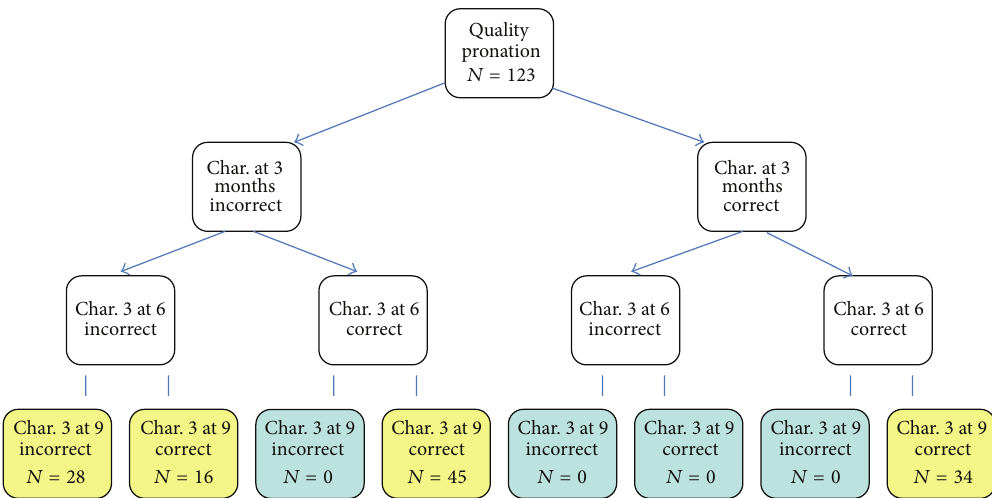
Figure 1: Analysis of qualitative development in the prone position at 3, 6, and 9 months.